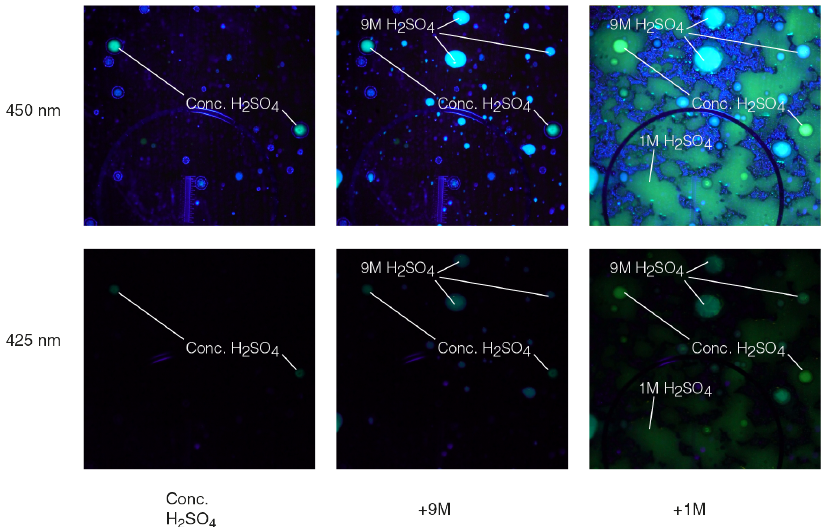
Figure 11. Images of the same slide (7% PVA, 6% uranin, made using 12 µ m bar coater) covered in droplets created with sequential spraying of mist of different concentrations on the slide.